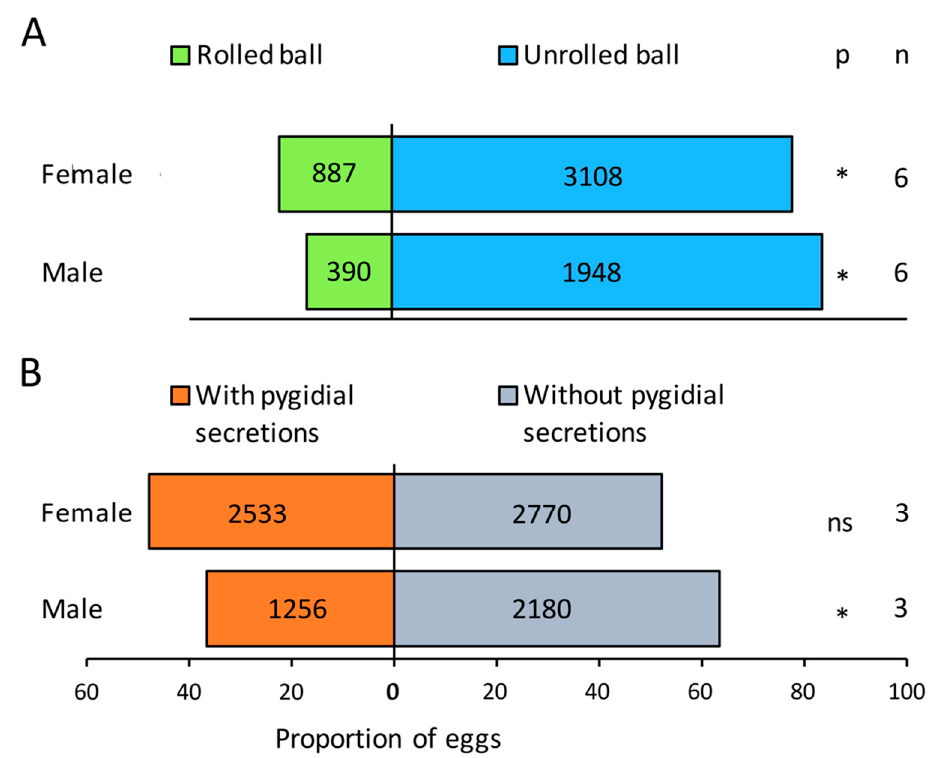
Figure 3. The relative proportion of eggs laid by Lucilia cuprina on ( A ) controlled food balls and balls rolled by either Deltochilum furcatum males or females, or ( B ) balls treated with pygidial secretions from field collected D. furcatum males or females. * = p < 0.05; ns = no significant difference. The values inside the bars indicate the total number of L. cuprina eggs.